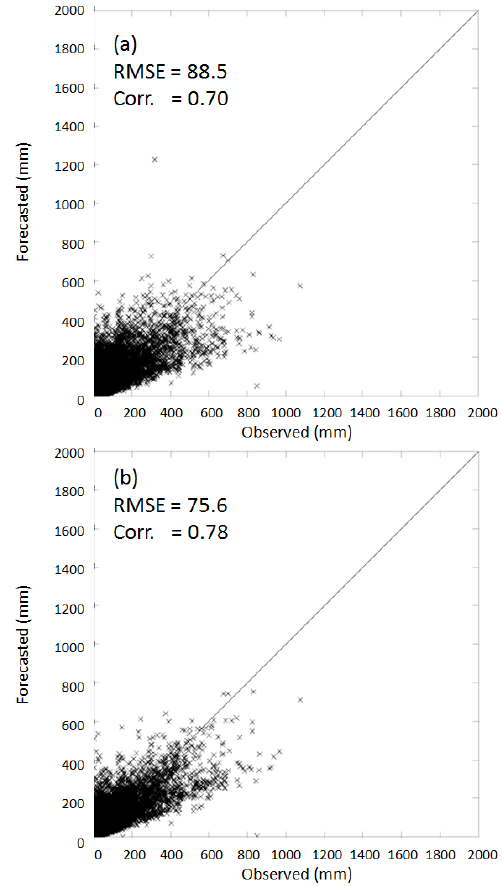
Fig 6. The forecasted (y axis) and observed (x axis) rainfall accumulations of the 2 Fig. 6. The forecasted (y-axis) and observed (x-axis) rainfall ac- dependent northward-moving typhoons (from 1989 to 2006) for all rain gauge stations: 3 cumulations of the dependent northward-moving typhoons (from (a) TRCM06; and (b) N-TRCM12. 4 1989 to 2006) for all rain gauge stations: (a) TRCM06; and (b) N-